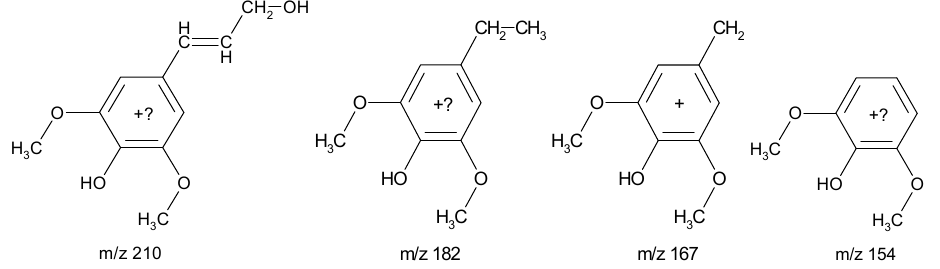
Figure 5. Presumed fragmentationof sinapyl alcohol. The acetosyringic acid has (Figure 6) not been fully identified by the used MS spectral library. The MS spectrum shows significant similarity to syringic acid and lesser similarity to acetosyringone, but has an intense band corresponding to m/z 256. This may correspond to acetosyringic acid or be the result of fragmentation of an even larger molecule in which the hydroxyl group of syringic acid occurs as an ester. Ralph and Lu [71] reported that the acetylation of syringic compounds in position 4 may be the result of biological processes and that such groups are often found in the lignin of deciduous trees and dicotyledons. Structural units of lignin may also occur in the form of coumaric acid esters [72]. For willow and aspen wood, the hydroxyl group in position 4 often occurs in the form of p-hydroxybenzoate [71]. This type of ester linkage is also known to occur in tannins— digallicand trigallic acids are known